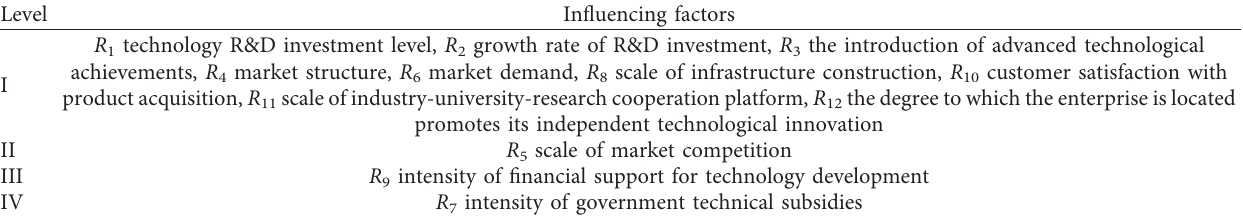
Table 6: Hierarchy of hidden important influencing factors for the realization of technology independent innovation in equipment manufacturing enterprises.